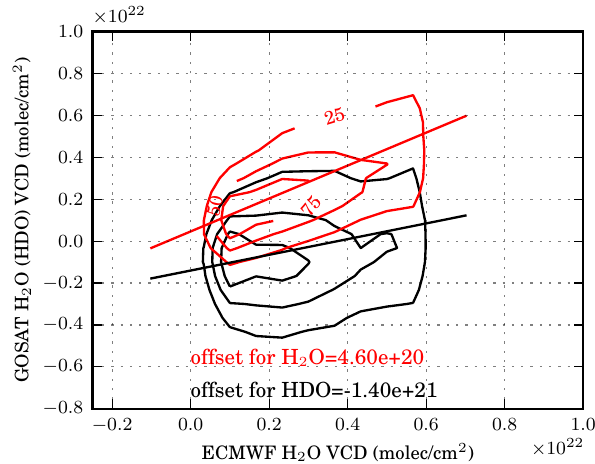
Fig. 2. Frequency distribution and linear fit of retrievals and ECMWF estimates over very dry regions (mostly Antarctica coin- cidences chosen here). Contour lines show 25, 50 and 75 percentile distributions. Small offset errors in both HDO and H 2 O column es- timates can be observed, and fitted offsets are used in the subsequent bias